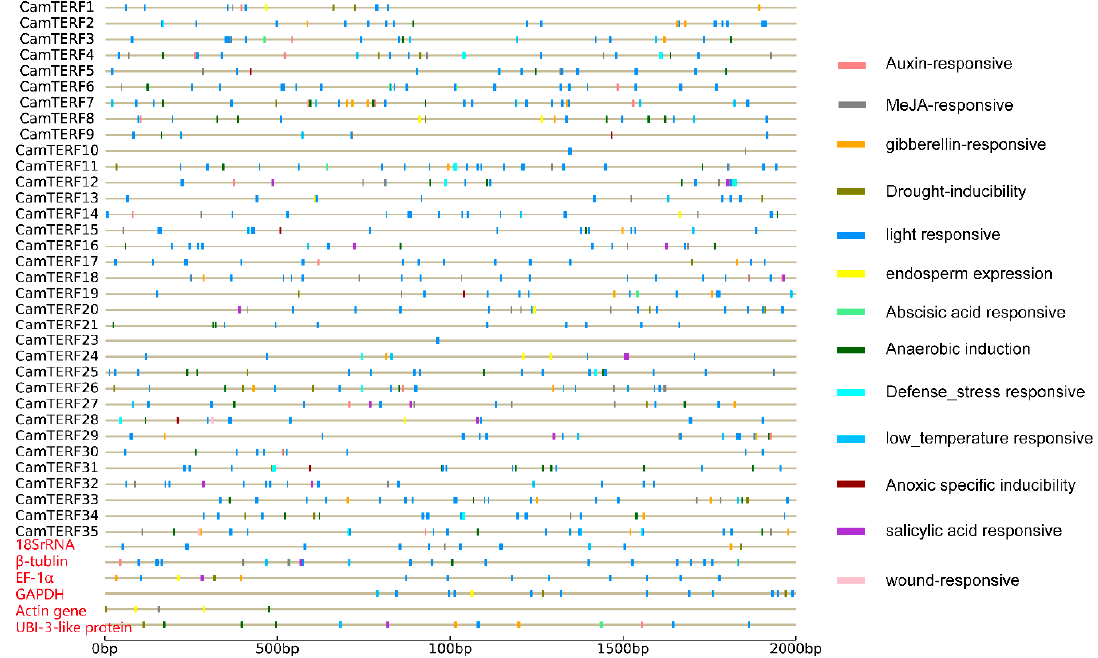
Figure 5. Predicted cis-elements in CamTERFs promoters. Promoter sequences ( − 2000 bp of translation start site) of 35 CamTERFs (promoter sequence of CamTERF22 was omitted) and 6 housekeeping genes were analyzed by PlantCARE.